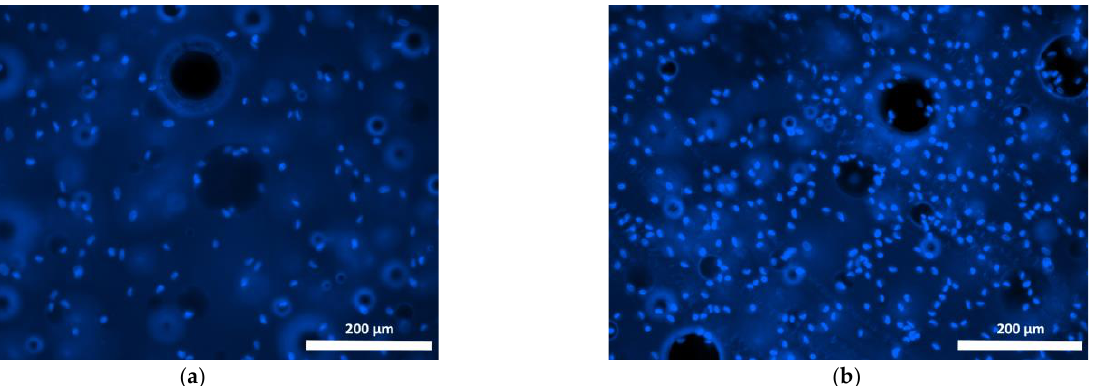
Figure 5. Fibroblast nuclei on the surface of basic Composition 1 specimen (staining fluorochrome — Hoechst 3334, BD Pharmingen ™ ; mag. 100×): ( a ) 24 h cultivation; ( b ) 72 h cultivation.